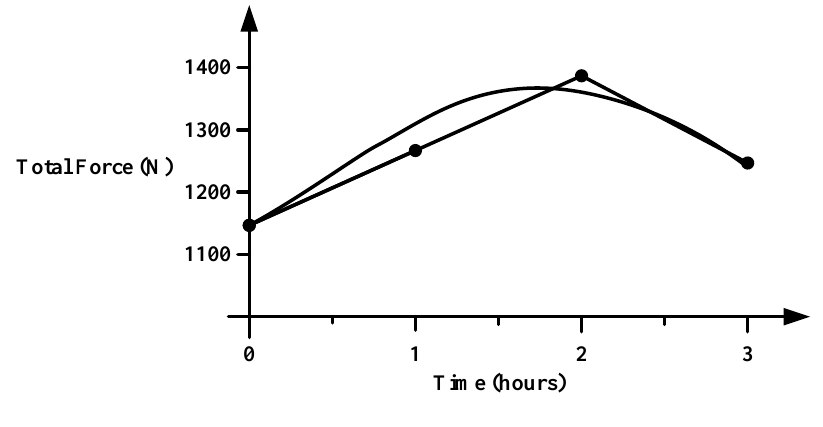
Figure 9. Example of erroneous readings due to sensor creep of Pedar ® Insole. The curve is the error reading by the sensor and plotted line is the correct pressure values. Modified from